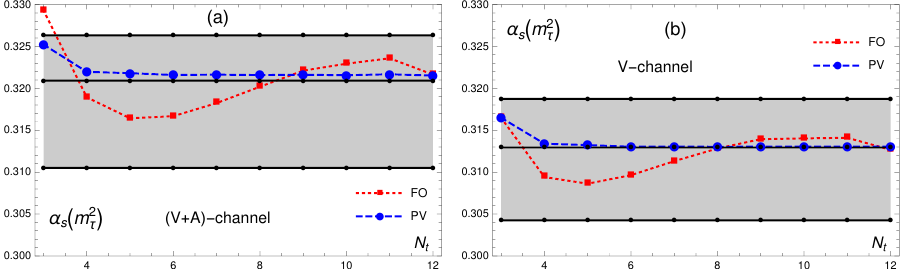
Figure 1. (coloured online) (a) The values of α s ( m 2 ) extracted from the Borel-Laplace sum rule of the τ (V + A)-channel, as a function of the truncation index N t , for each of the two methods (FO, PV). The light grey (blue) band represents the band of the final averaged values for the (V + A)-channel [cf. Eq. (31)]. (b) The same, but extracted from the V-channel